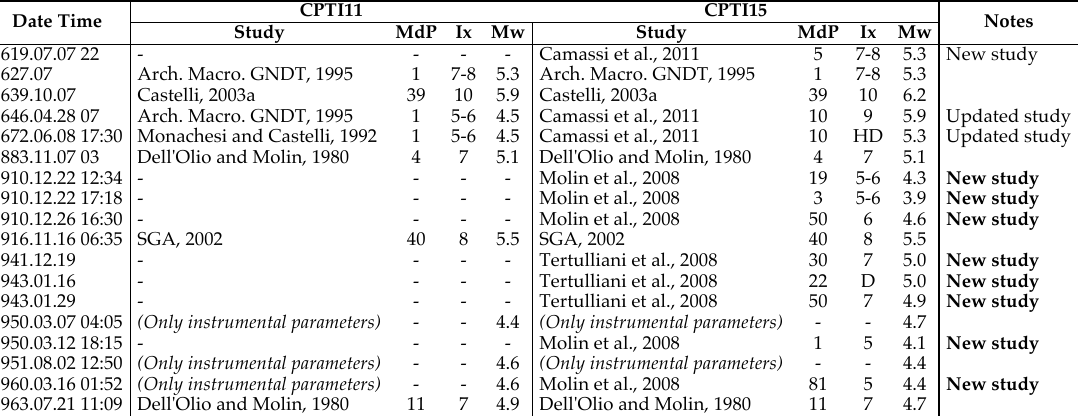
Table 1: Comparison of the background of the CPTI11 and CPTI15